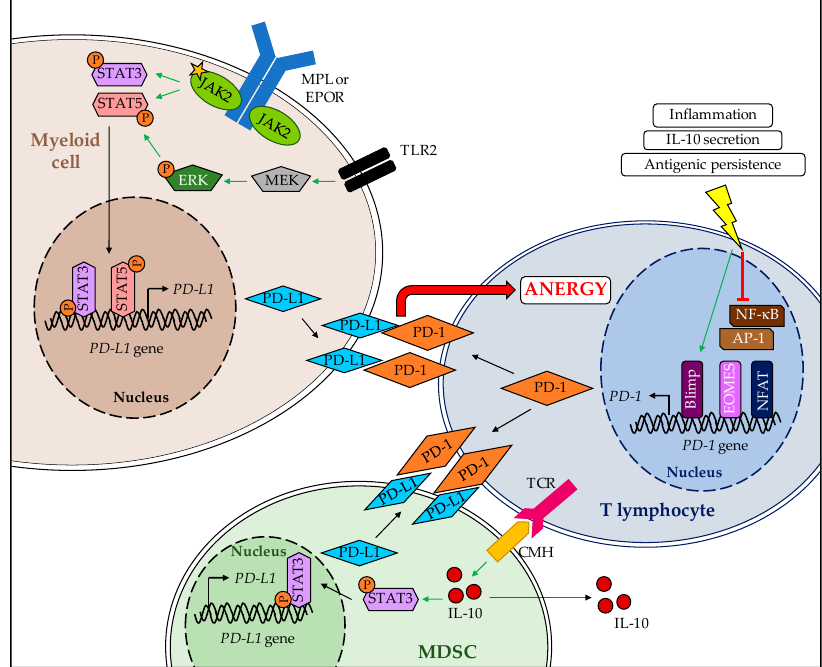
Figure 2. Role of PD-1/PD-L1 axis in MPN and its regulation. Constitutive activation of JAK2 receptor in myeloid cells leads to STAT-dependent expression of PD-L1, which then binds to PD-1 receptor